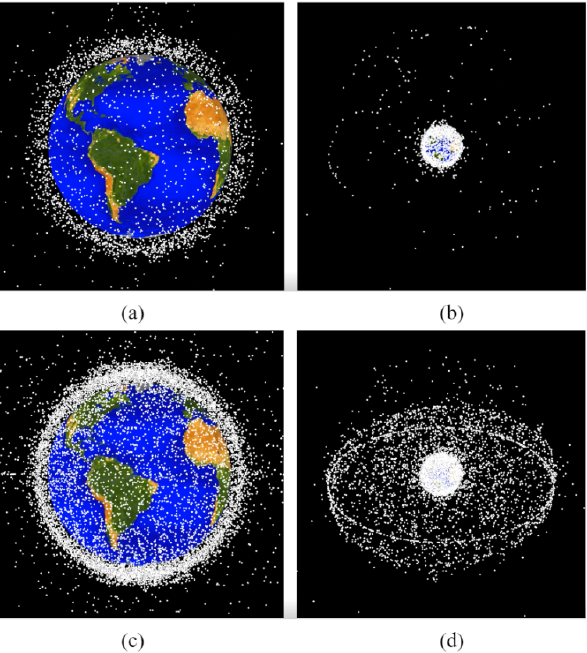
Figure 1. Progression of the space debris formation surrounding Earth from 1975 ( a , b ) to 2019 ( c , d ) with a minimum of 10 cm in diameter as modeled by NASA’s Orbital Debris Program Office (ODPO) [6] . Image usage is consistent with NASA policy, “NASA content (images, videos, audio, etc.) are generally not copyrighted and may be used for educational or informational purposes without needing explicit permissions.”